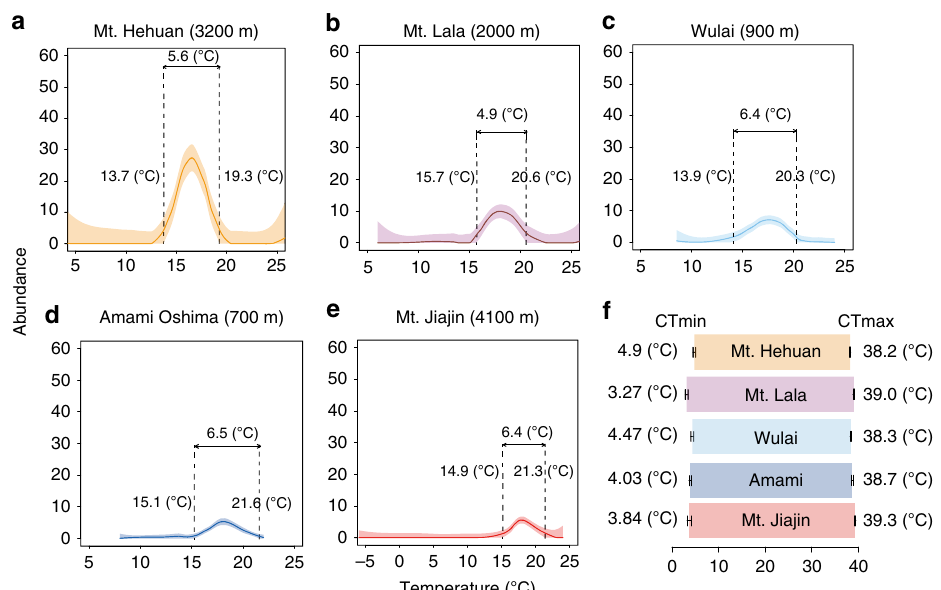
Fig. 3 Burying beetle abundances along the elevational temperature gradients, and their thermal niche spaces and thermal tolerance ranges for each of the fi ve mountain ranges. The thermal niches of the a Mt. Hehuan, b Mt. Lala, c Wulai, d Amami Oshima, and e Mt. Jiajin populations, the line and polygon areas are fi tted trend and con fi dence intervals from the non-parametric regression (LOESS), and f the thermal tolerance ranges, de fi ned as CTmax minus CTmin, of fi ve populations. The standard error was presented as the error bar. The maximum elevation of each mountain range is given in parentheses.